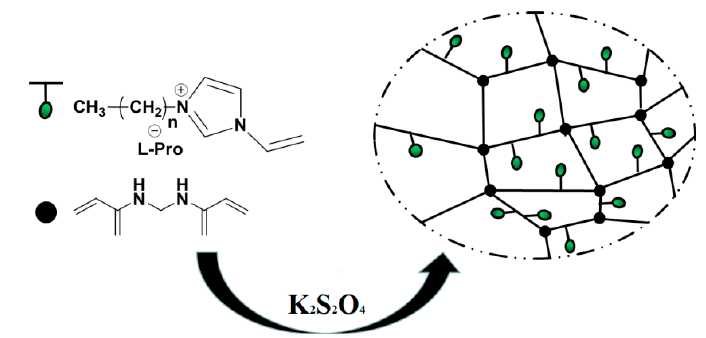
Figure 1. The synthesis of ( a ) ViImCn-L-Pro and ( b ) (ViIm) 2 C n (L-Pro) 2 .